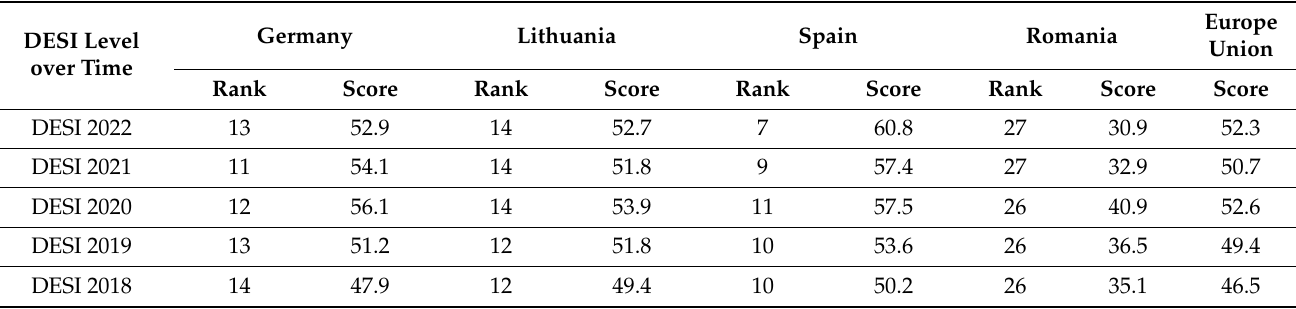
Figure 1. The level of the DESI across the EU. Table 3 shows the overall digitization scores for Germany, Romania, Lithuania, and Spain from 2018 to 2022 compared to the European average. The overall degree of digitization in the EU is high, but some countries are lagging behind, such as Romania. The pandemic caused a reduction in the adoption of digitization across Europe [20]. Table 3. Overall level of the